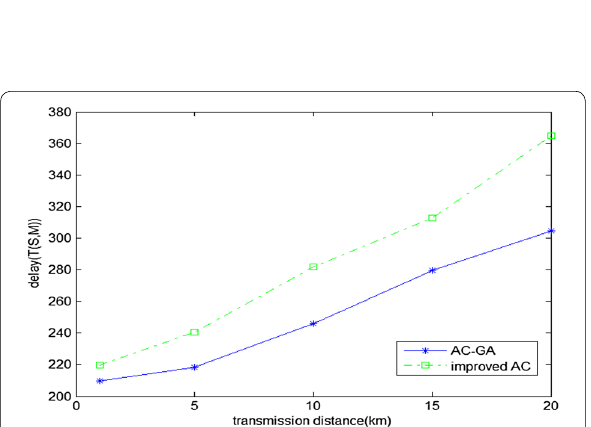
Figure 7 Optimization process of cost effectiveness fitness in AC‑GA